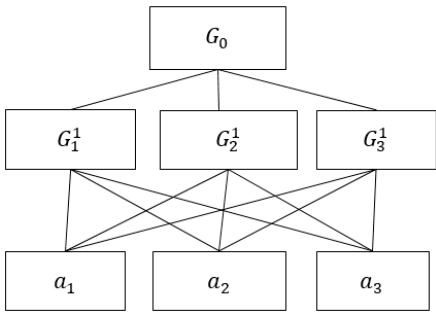
Table 2. Description of elements in Figure 3.